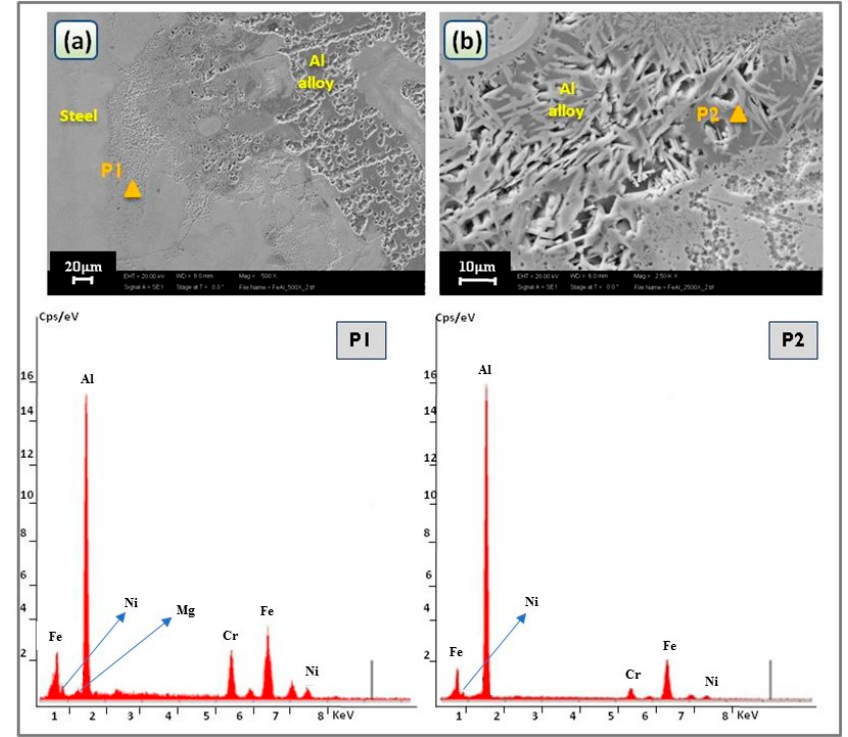
Figure 12. SEM micrographs of the IMC zone of the cross section with energy dispersive spectroscopy (EDS) analysis results in the highlighted points P1, P2 at ( a ) 5000× and ( b ) 10000× magnifications.